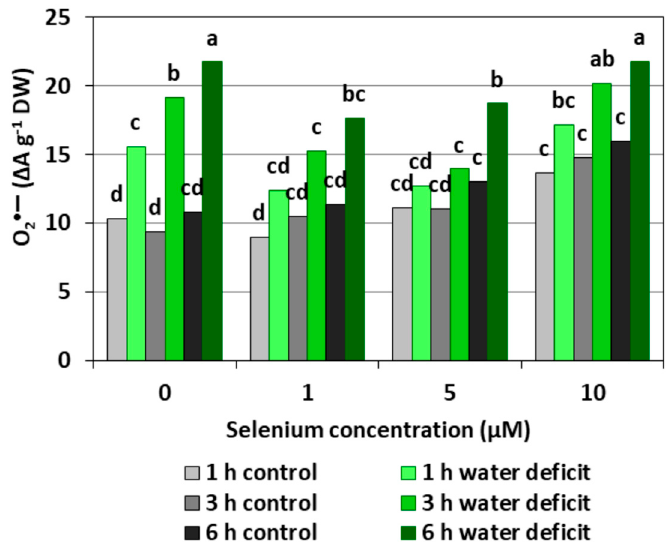
Figure 1. The superoxide anion radical (O 2 •− ) level in the roots of cucumber seedlings pre-treated with selenium (Se) and subjected to a water deficit (WD). Bars marked with the same letters do not differ significantly at p < 0.05.